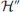
Example for the application of this method for detecting AF.(A) The original HR sequence hr
n; (B) The distribution of symbols sy
n; (C) The relevant word sequence wv
n of sy
n in (b), and (D) The distribution of SE H" (A).